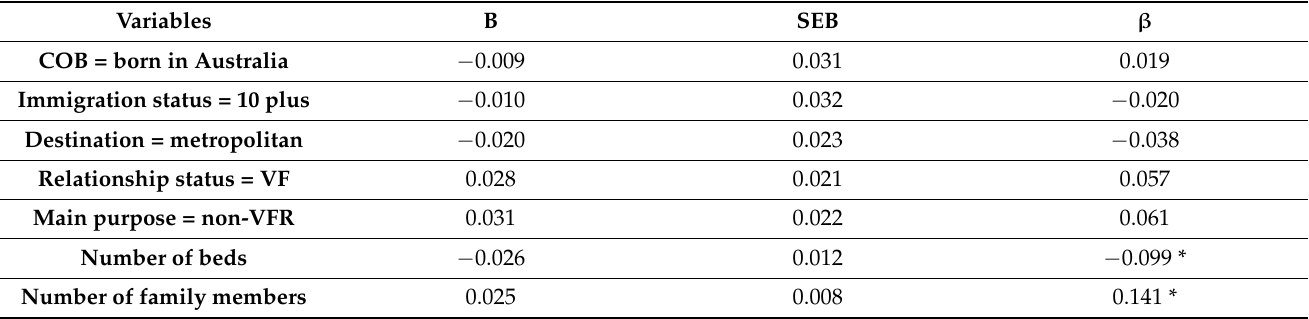
Table 9. Regression analysis summary for the host’s variables predicting the number of VFRs staying in commercial